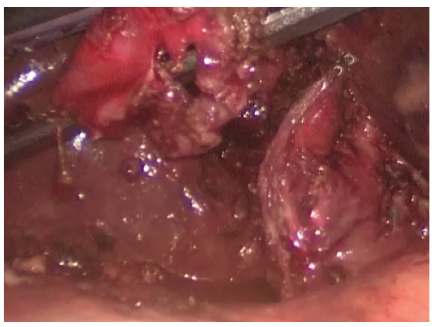
Figure 4: Applied Tri-Staple line is seen on